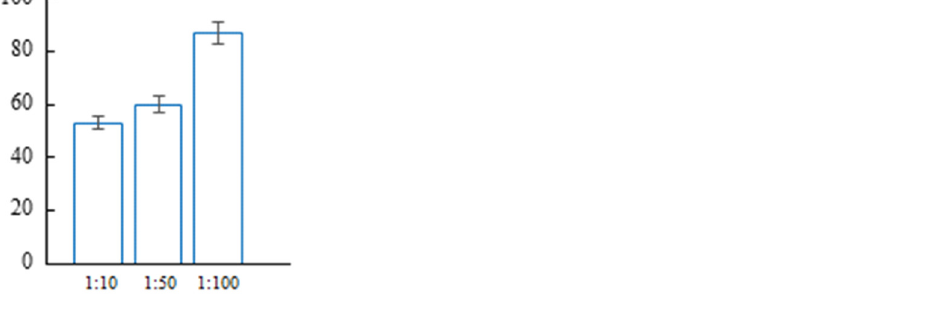
Figure 7. Allelopathic effect of aqueous extract of aboveground parts of Cánnabis satíva on seedlings of Cucumis sativus L.